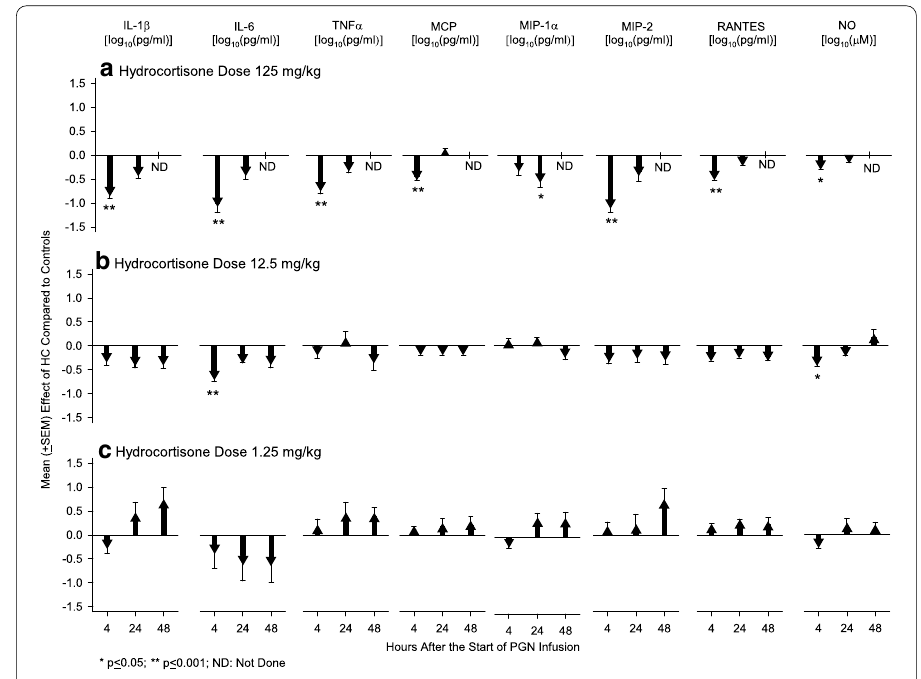
(Fig. 3, Additional file 1: Table S3). Medium-dose HC decreased ALT, AST, and CK at 4, 24 and 48 h and these decreases were significant for each parameter at 24 h ( p 0.05) as well as when averaged over the three time points ( p ≤ HC did not alter these parameters significantly ( p > 0.05 for all).